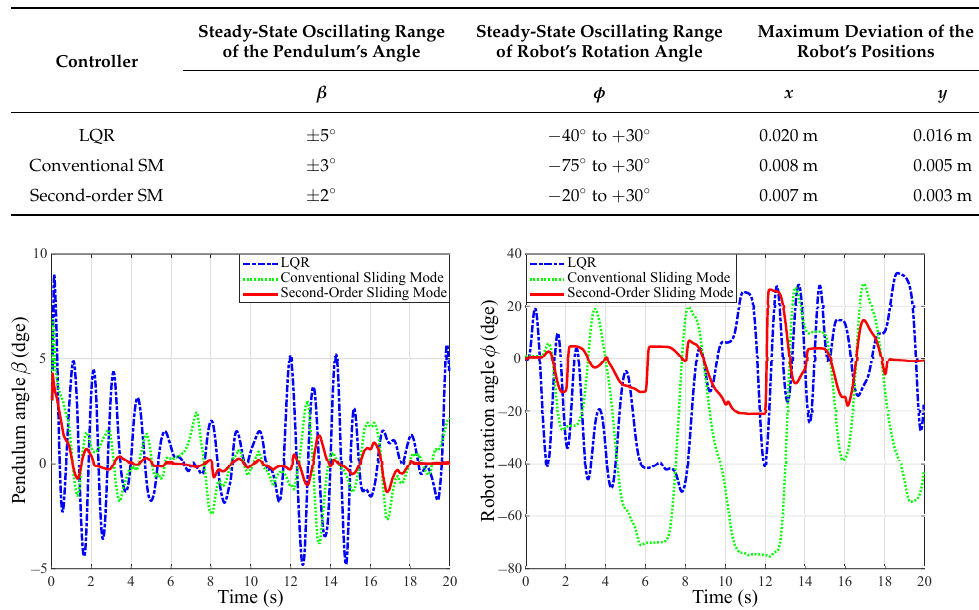
Figure 17. The experimental results compare the angle responses of the inverted pendulum on β and the robot on φ , respectively.